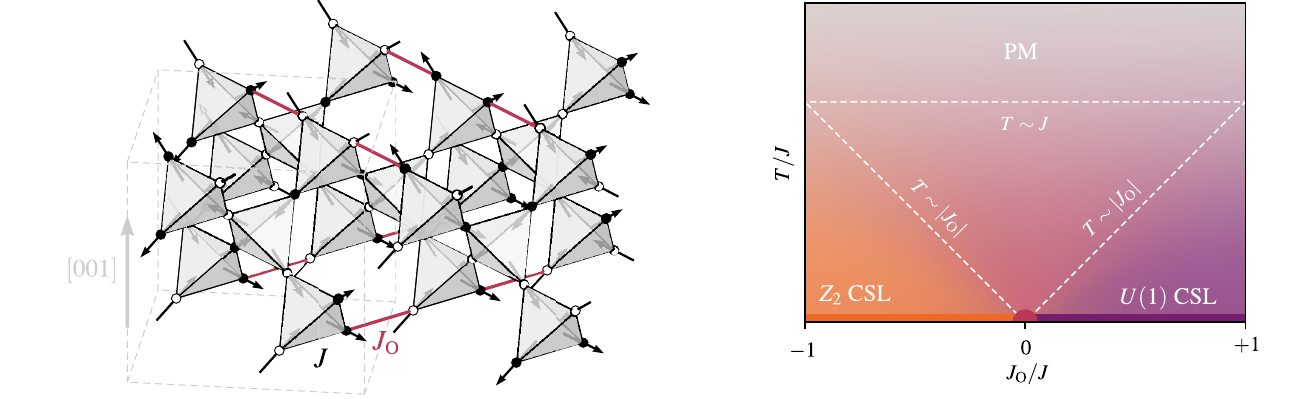
.FIG. 1. Spin-ice film of thickness L ¼ 1 . The magnetic ions form a pyrochlore lattice, composed of corner-sharing tetrahedra. Cleaving the surfaces perpendicular to the [001] direction exposes orphan bonds on the top and bottom surfaces, not belonging to any complete tetrahedron (shown in red). These orphan bonds have an exchange coupling J the other bonds, J